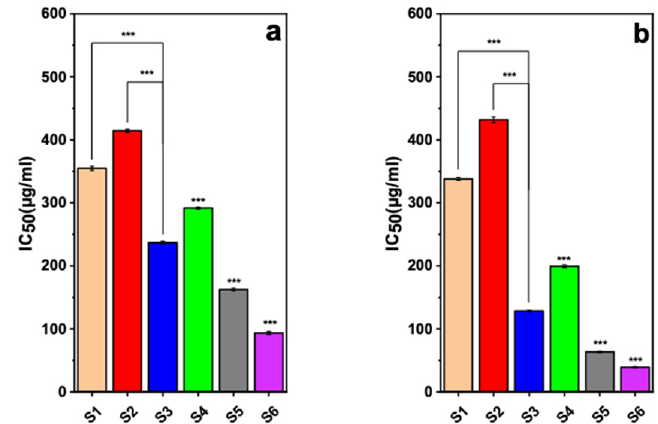
Figure 3. Investigation of cell viability for ( a ) MDA-MB-231 and ( b ) SK-BR-3 breast cancer cell lines using MTT assay. S1: letrozole; S2: curcumin; S3: mixture of letrozole and curcumin; S4: NiCoFe 2 O 4 @L-Silica@Niosome; S5: NiCoFe 2 O 4 @L-Silica@L-Niosome; S6: NiCoFe 2 O 4 @L-Silica@C-Nio- some (*** p < 0.001).